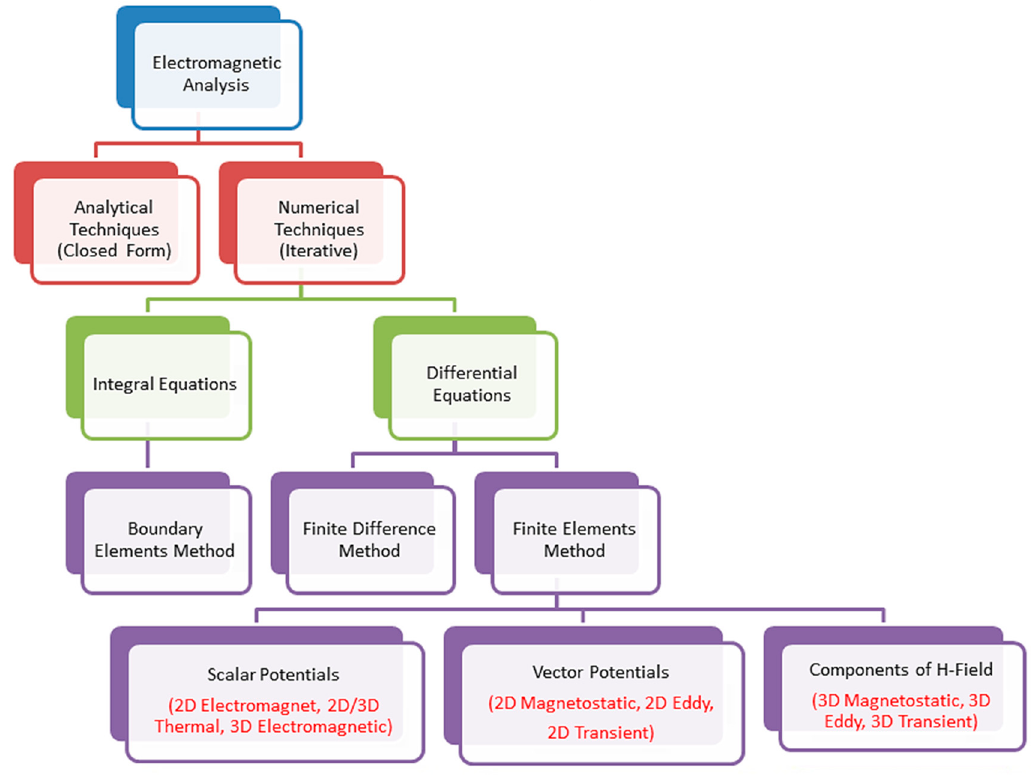
ff erent methods of electromagnetic analysis Figure 13. Different methods of electromagnetic analysis [57]. Figure 13. Di